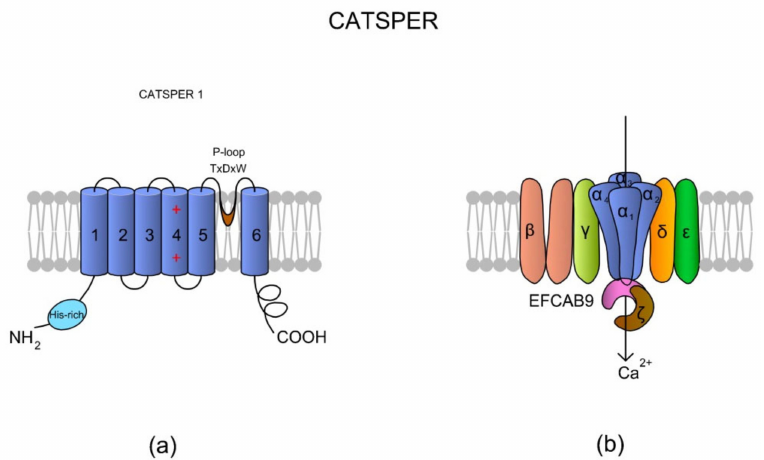
Figure 3. A topological and spatial structure of CatSper. ( a ) The α 1 subunit created by CatSper1. Like most voltage-gated channels, each α subunit contains six transmembrane domains (TM1–TM6) creating two physiologically distinctive regions, namely the voltage-sensing domain (VSD; TM1–4) and pore-forming region (TM5–6). Each TM4 contains several (two to six) positively charged amino acid residues that serve as voltage sensors (reviewed in Reference [57]). Voltage slopes move TM4, resulting in conformational changes that open and close the channel pore [64]. Additionally, a short and hydrophobic cyclic structure linking TM5–6 contains a conserved homologous amino acid sequence (T × D × W), which selectively permits Ca 2+ influx. The N-terminus of CatSper 1 contains a specific histidine-rich region that might be involved in the pH regulation of CatSper activity. ( b ) The topological localizations of all auxiliary subunits are not randomly organized. The auxiliary CatSper β subunit has two predicted TMs that are separated by a large (ca. 1000 amino acids) extracellular loop [64], whereas CatSper γ , CatSper δ , and CatSper ε feature only one TM. Brown et al. [69] suggested that CatSper ζ is a late evolutionary adaptation to maximize fertilization success inside the female mammalian reproductive tract. The predicted topology of Hwang et al. [62] situates the CatSper ζ and EFCAB9 subunits as a cytoplasm complex that is located just below the CatSper 1–4 subunits. This complex interacts with the channel pore as a gatekeeper. The increase in pH i causes Ca 2+ binding to highly conserved EF-hands of EFCAB9, leading to dissociation of the EFCAB9-CatSper ζ complex and full activation of the channel. Accordingly, EFCAB9-CatSper ζ appears to be responsible for both modulation of the channel activity and organization of the CatSper domains [62]. The scheme has been prepared based on Reference